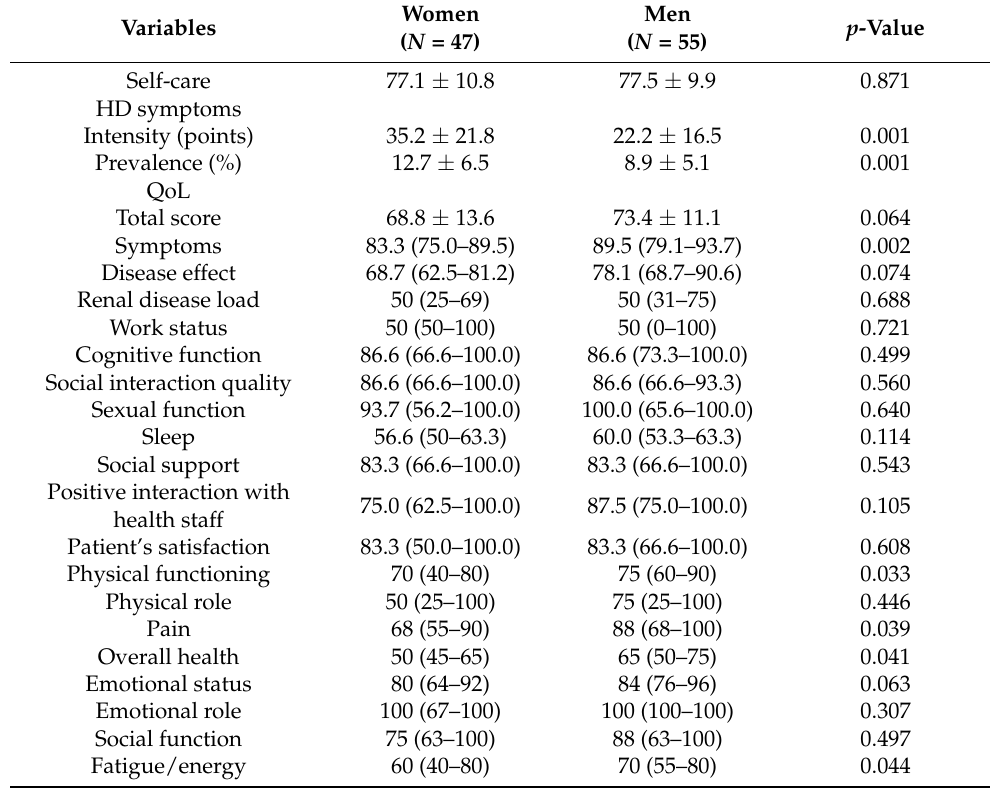
Table 3. Self-care, hemodialysis (HD) symptoms, and quality of life (QoL) of the study participants. Data are shown as mean ± standard deviation or median (percentile 25–percentile 75).